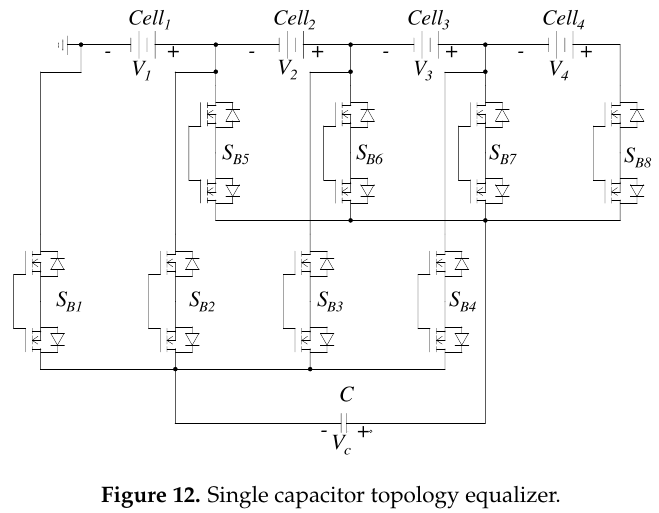
Figure 12. Single capacitor topology equalizer.